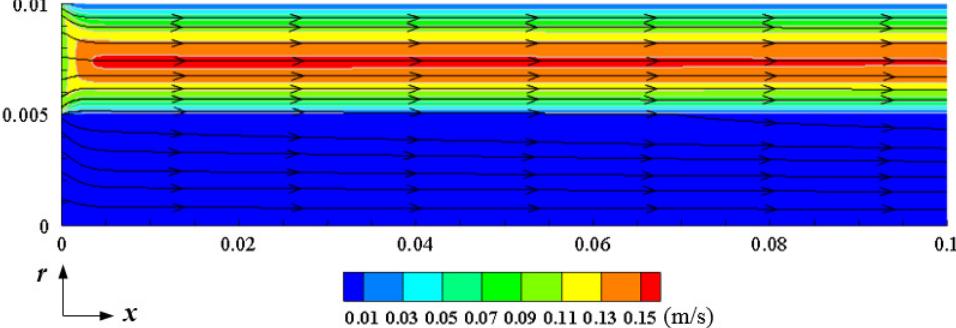
Figure 6. Flow pattern and velocity contour in x − direction under reactive flow ( x / r = 0.4).